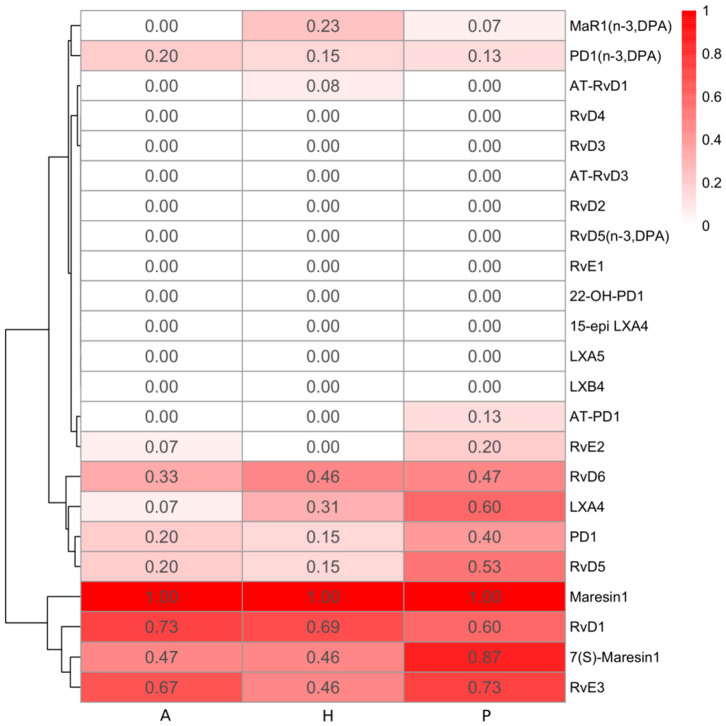
Heatmap of specialized pro-resolving lipid mediator (SPM) detection frequency. The detection frequency is calculated based on the number of samples where the specific SPM is detected divided by the total number of samples in each group (A: periodontitis after non-surgical therapy; H: healthy; P: periodontitis before non-surgical therapy). The color intensity reflects the calculated detection frequency.